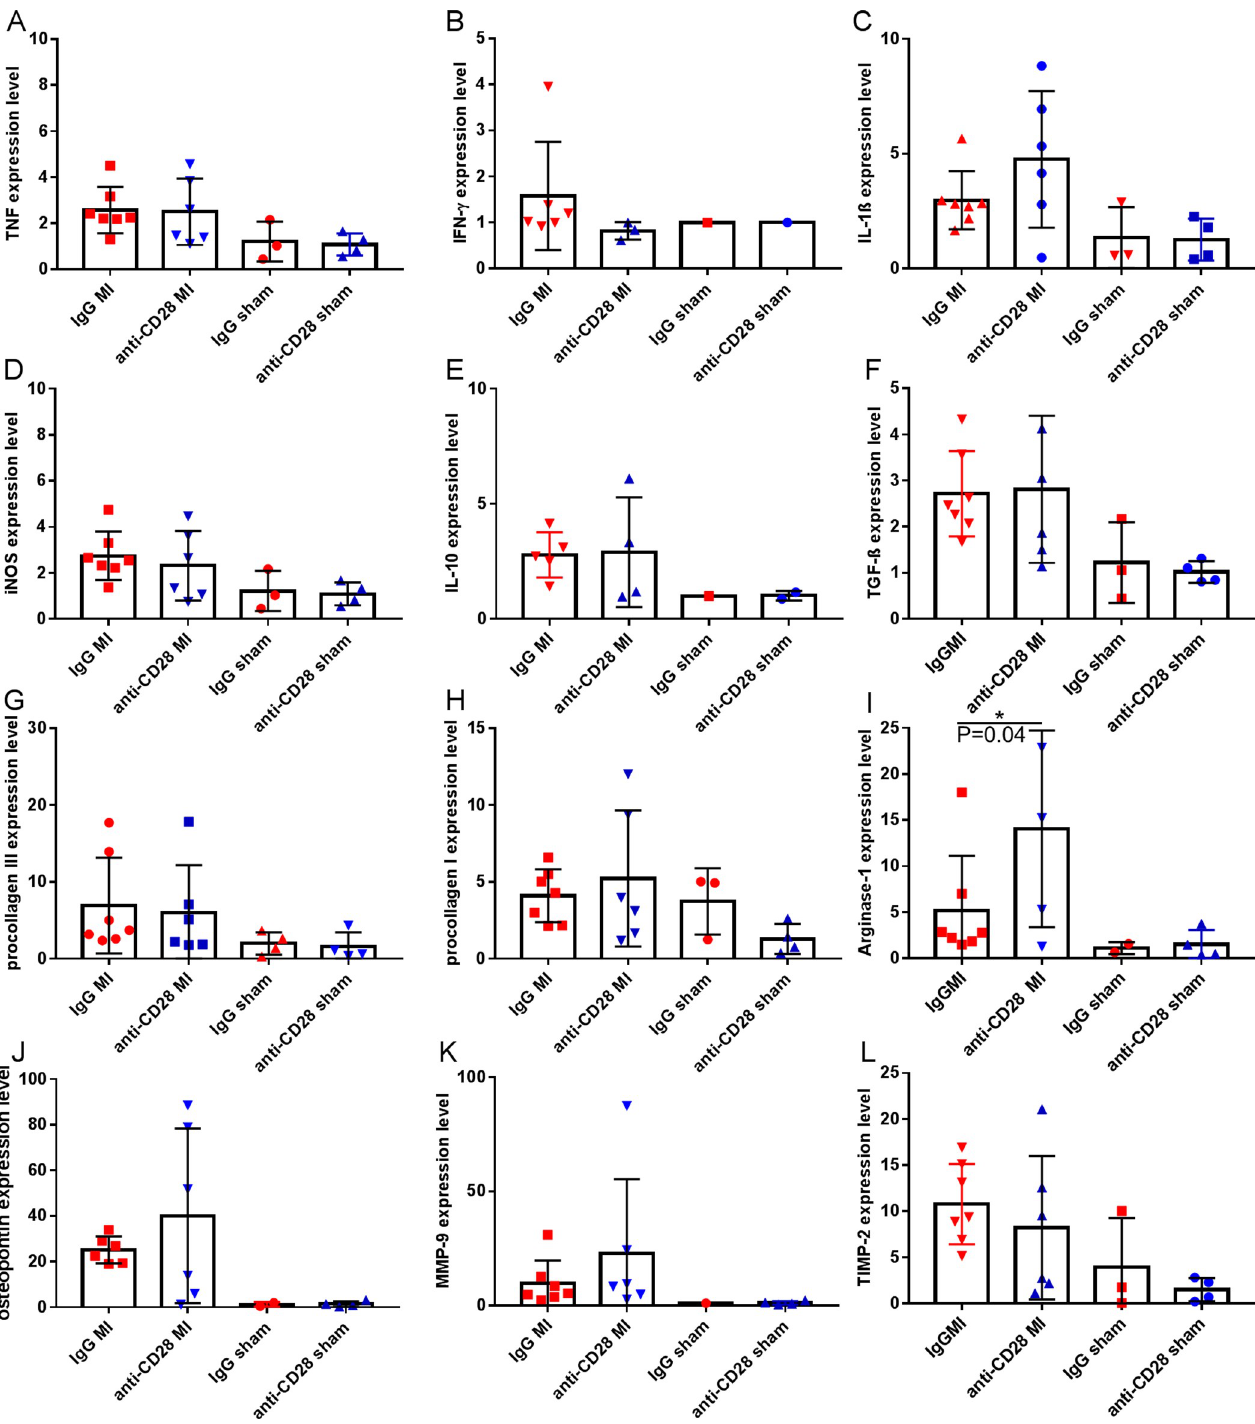
Fig 5. Quantitative real-time PCR analysis reflecting the relative transcription of proteins representing inflammation (A-D), pro-fibrotic/ anti-inflammatory proteins (E-J), and matrix-protease activity (K, L) at 5 days after MI or sham surgery. Transcripts reflecting arginase 1 expression were significantly upregulated in the anti-CD28 vs IgG treatment group ( � P < 0.05 ANOVA, followed by Dunn’s multiple comparison test comparing the MI groups, means ± SD). A-L: n = 5–7 IgG MI, n = 3–6 anti-CD28 MI, n = 1–3 IgG sham, n = 1–4 anti-CD28 sham.